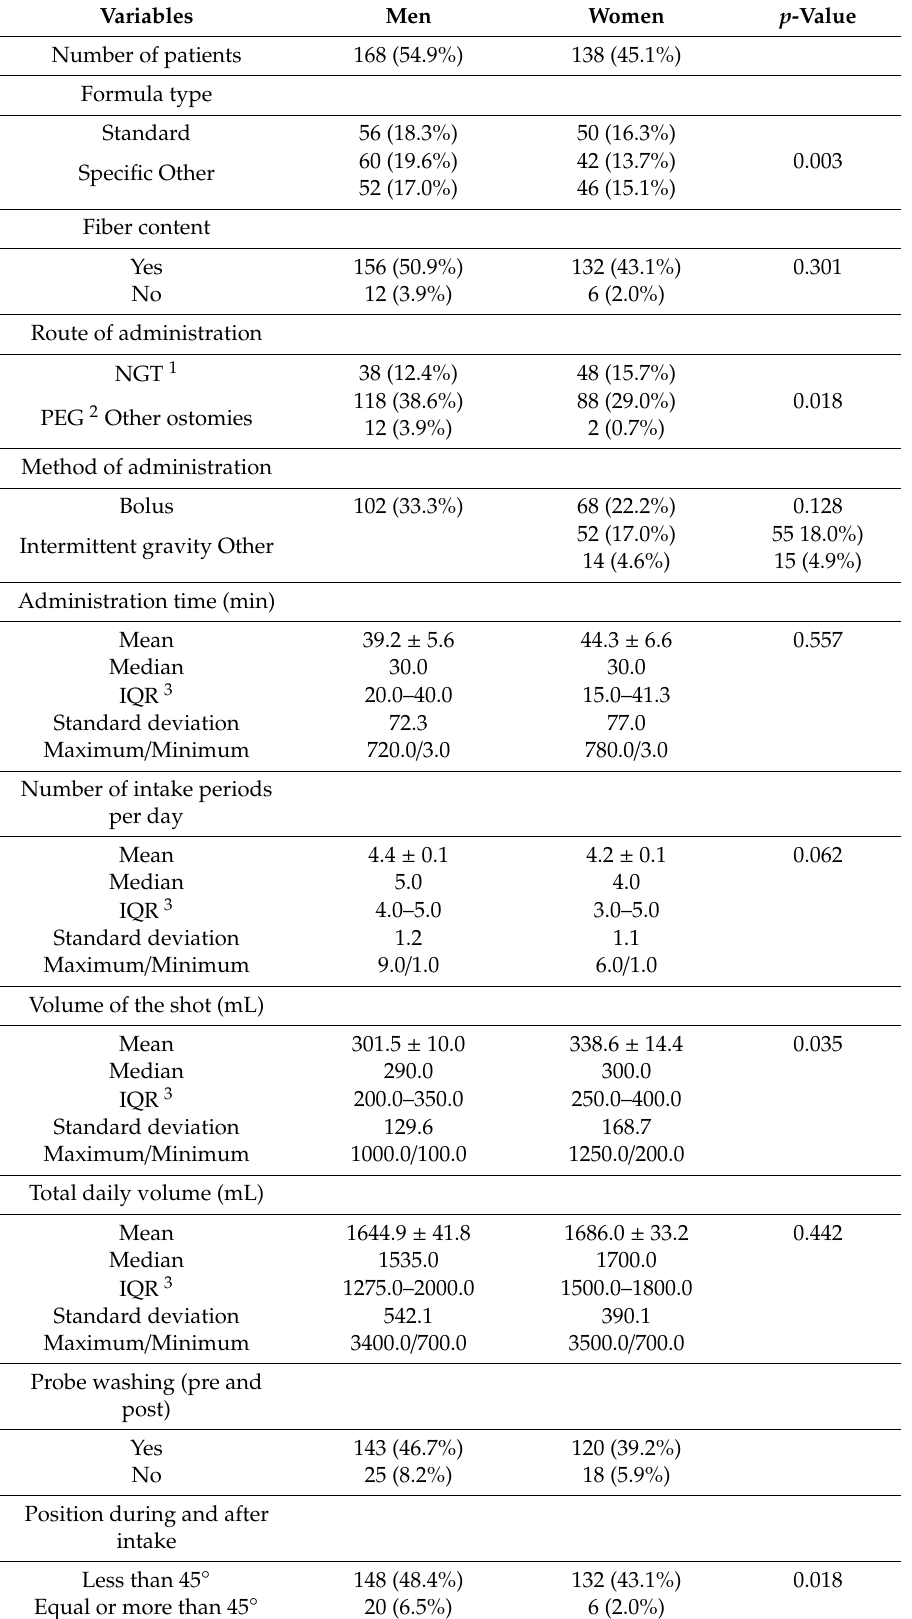
Table 2. Descriptive results related to HEN and its